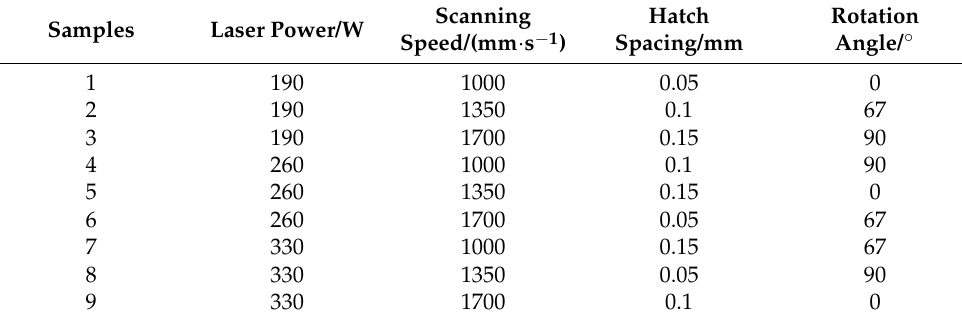
Table 2. Factors and level of Taguchi experiment.